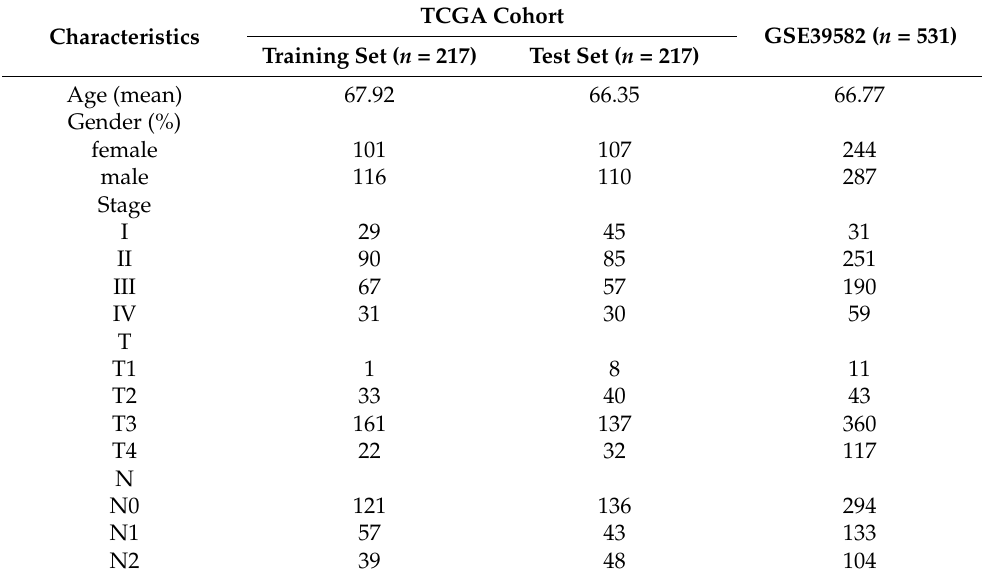
Table 1. Clinical characteristics of colon cancer patients.